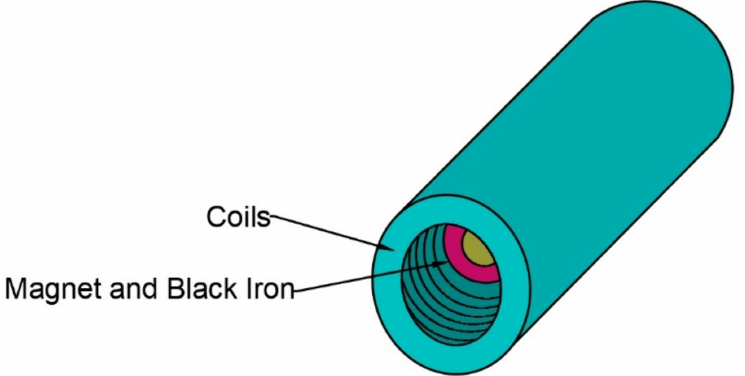
Figure 1. TLSM with stationary coils and a moving magnet [46,47].